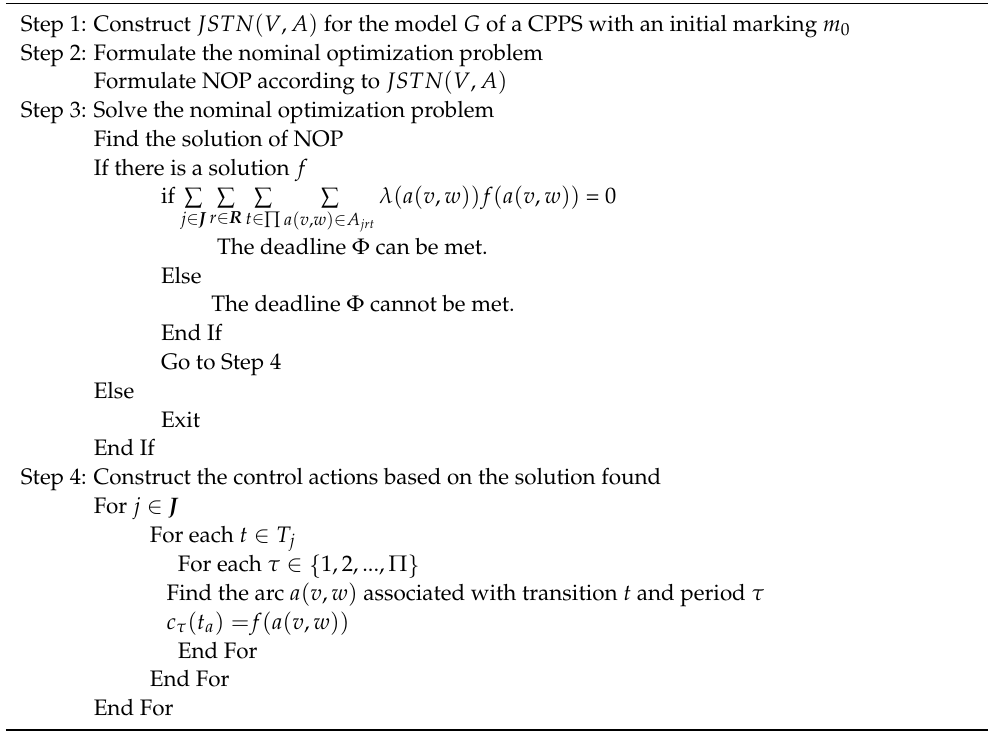
Algorithm 3: Context Generation Algorithm for